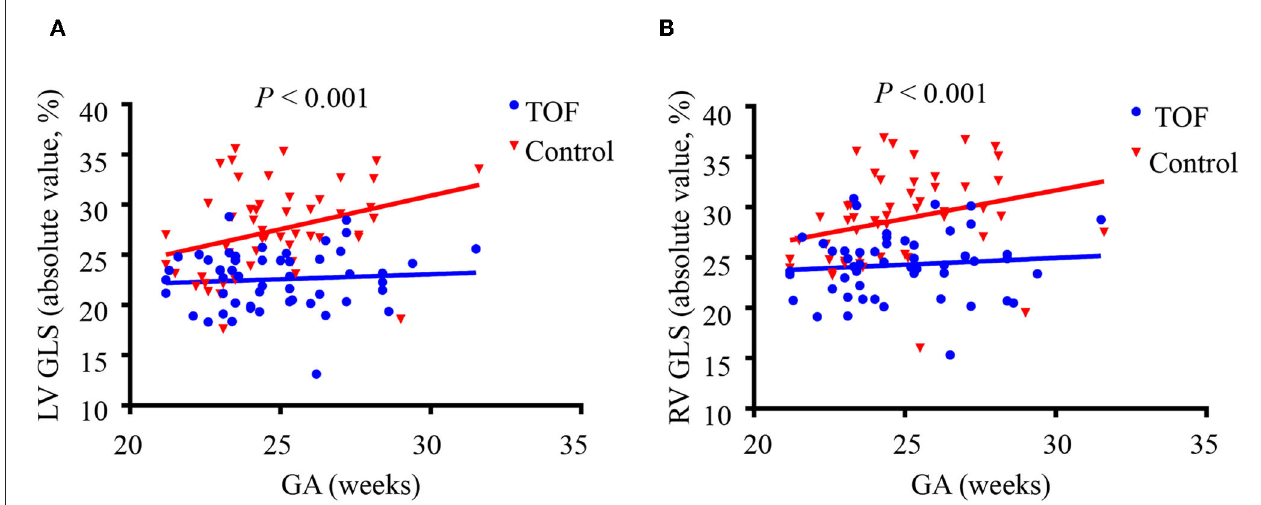
FIGURE 3 | Left ventricular (LV) and right ventricular (RV) global longitudinal strain (GLS) in fetuses with tetralogy of Fallot (TOF) and the control group shown across gestational age. (A) LV GLS is decreased in fetuses with TOF across all gestational ages compared to controls. (B) RV GLS is decreased in fetuses with TOF across all gestational ages compared to controls. P -values represent the difference between fetuses with TOF vs. control fetuses using a two-sample t -test.